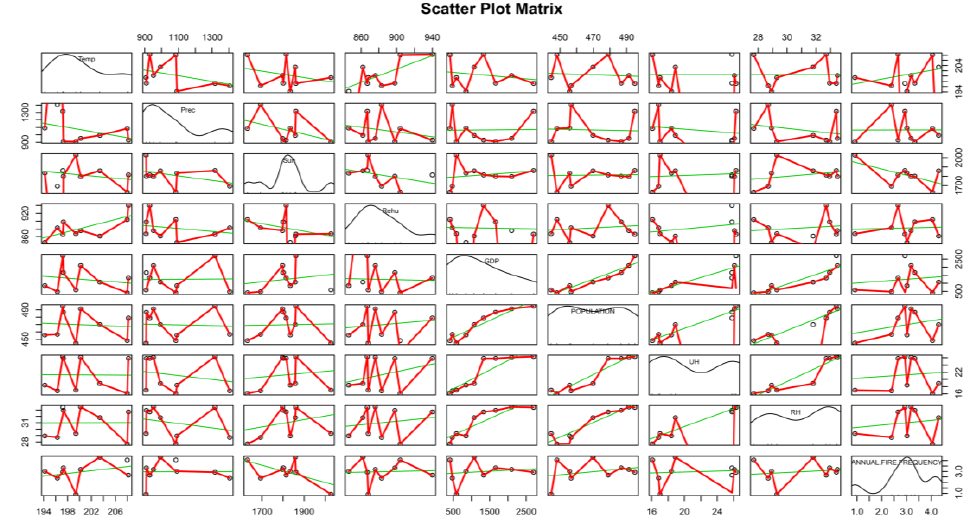
Figure 3. Scatter plot matrix for the internal relationships among annual predictors. Prec, Sun, Rehu, Sun, urban residents (UH), and rural residents (RH) are the abbreviations of precipitation, relative humidity, sunshine duration, temperature, average housing area of urban residents, and average housing area of rural residents respectively.